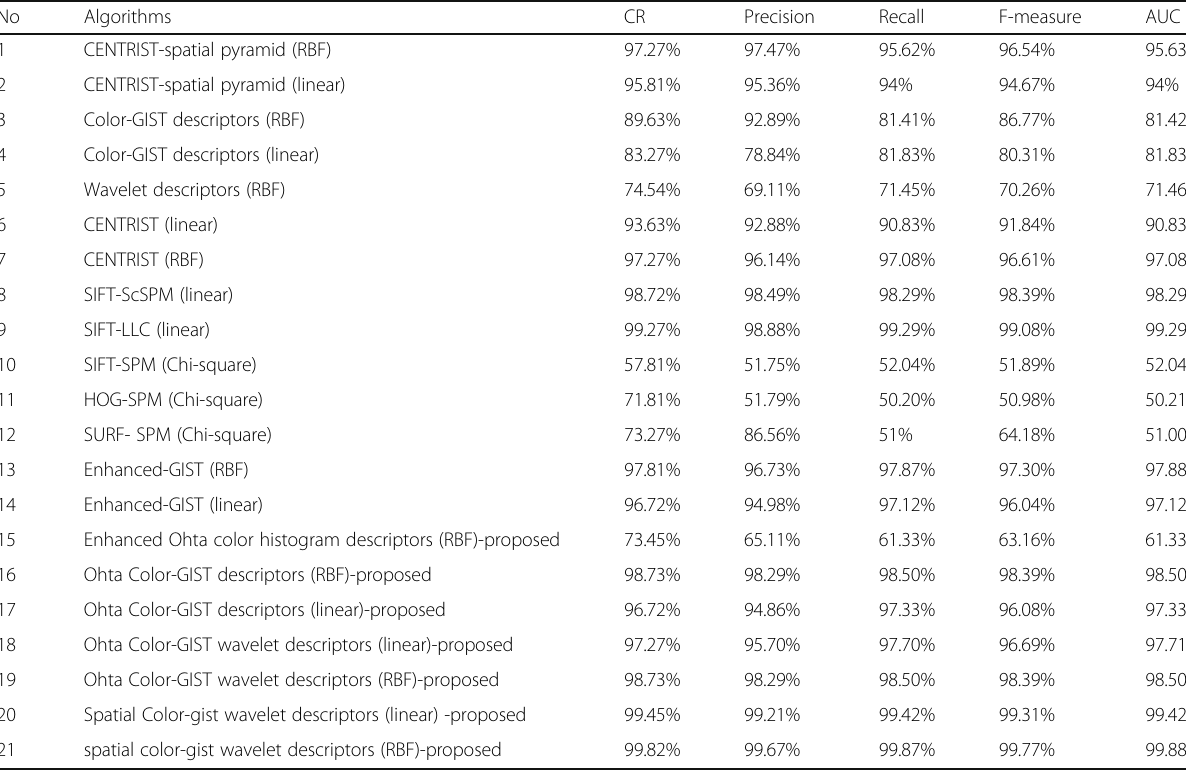
Table 2 Scene categorization performance on the Indoor Outdoor dataset